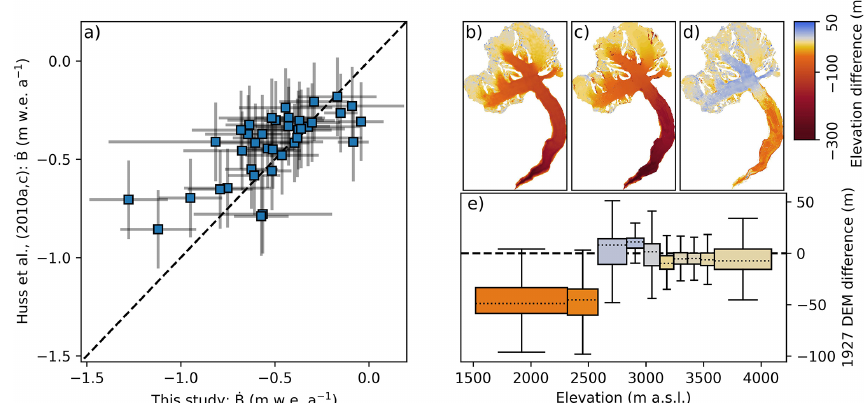
Figure 10. (a) Comparisons in the same time-intervals of 39 glacier-wide mass balances inferred in this study with mass balance derived from modelling, constrained by geodetic surveys at decadal intervals (blue squares; Huss et al., 2010a, c). The Pearson correlation coefficient between the points is 0.71. The horizontal uncertainty bars are the 95% confidence intervals of this study; the vertical uncertainties are fixed uncertainties of 0.2mw.e.a − 1 (see Sect. 5.1); the dashed line is a 1 : 1 line. (b) Elevation difference between the 1927 topographic map digitised and used by Bauder et al. (2007) and the SwissALTI3D DEM in 2017. (c) Elevation difference between the DEM mosaic generated in this study and the SwissALTI3D DEM in 2017. (d) Difference between the 1927 topographic map and the DEM mosaic from this study (map − this study). (e) Differences between the two 1927 DEMs (see d ) binned for every 10th percentile of elevation. A general agreement is seen on the upper part of the glacier (above ∼ 2700ma.s.l.), but the tongue is portrayed as smaller in the topographic